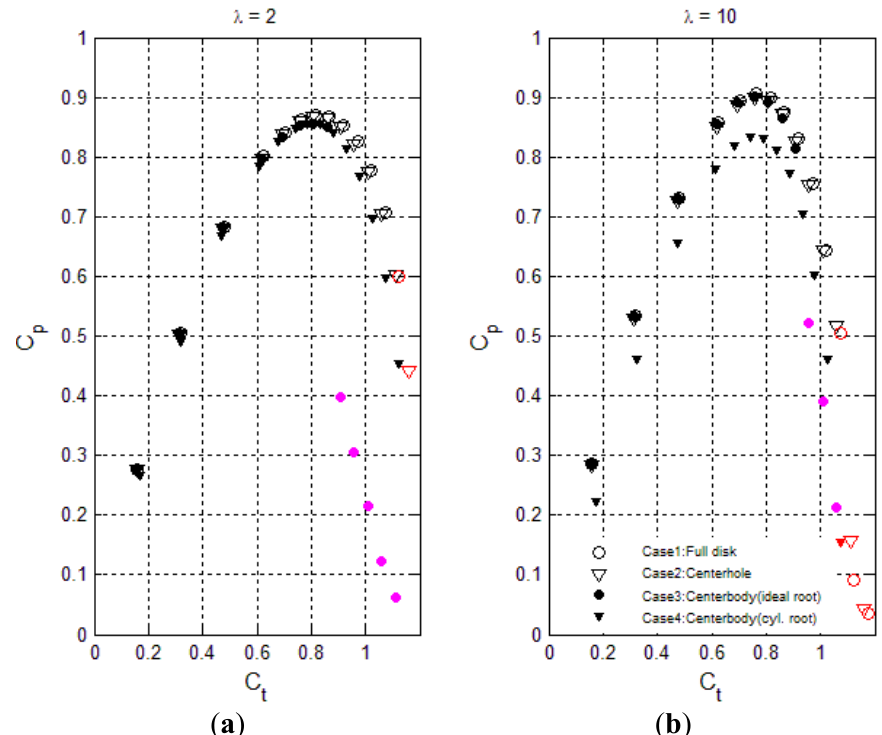
Figure 17. Rotor C T – C P performance plots for four different Hansen diffuser augmented wind turbines (DAWT) nacelle/rotors. ( a ) Low TSR = 2; ( b ) High TSR = 10.